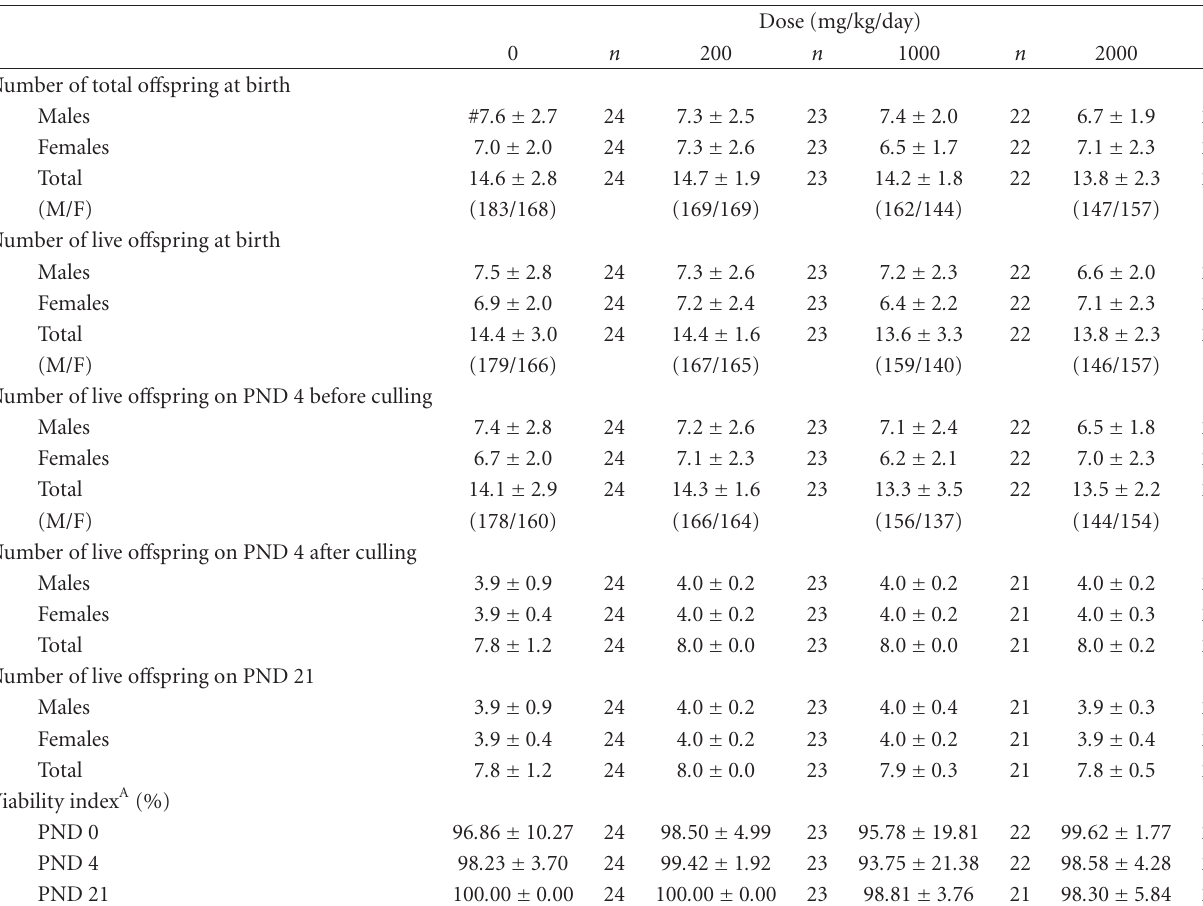
Table 10: Litter size and viability index of the F 1 generation rat pups exposed to SE5-OH during gestation and through lactation of the F 0